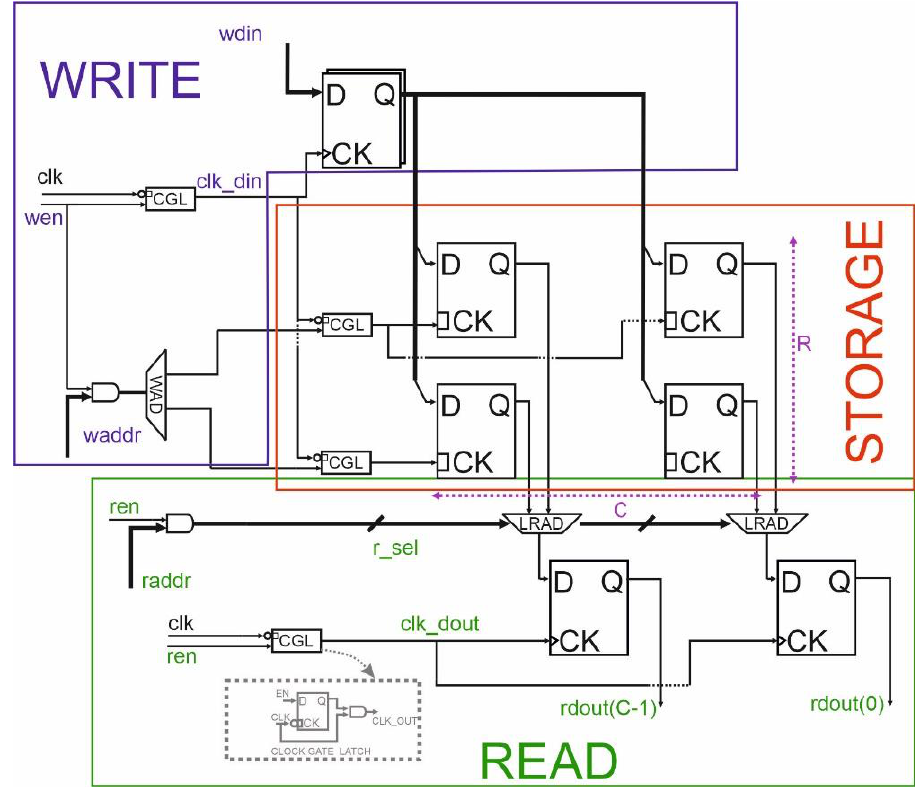
Figure 8. The embedded memory array is composed of RxC latches (R = C = 2 in this figure). The data (wdin) stored in the FFs register is written to the respective row by asserting its write enable (wen) coming from the Write Address Decoder (WAD). The read process involves Local Read Address Decoder (LRAD) to select the C latches composing the word. The grey box shows the implementation of the clock gate cell which let the clock signal pass if the enable is